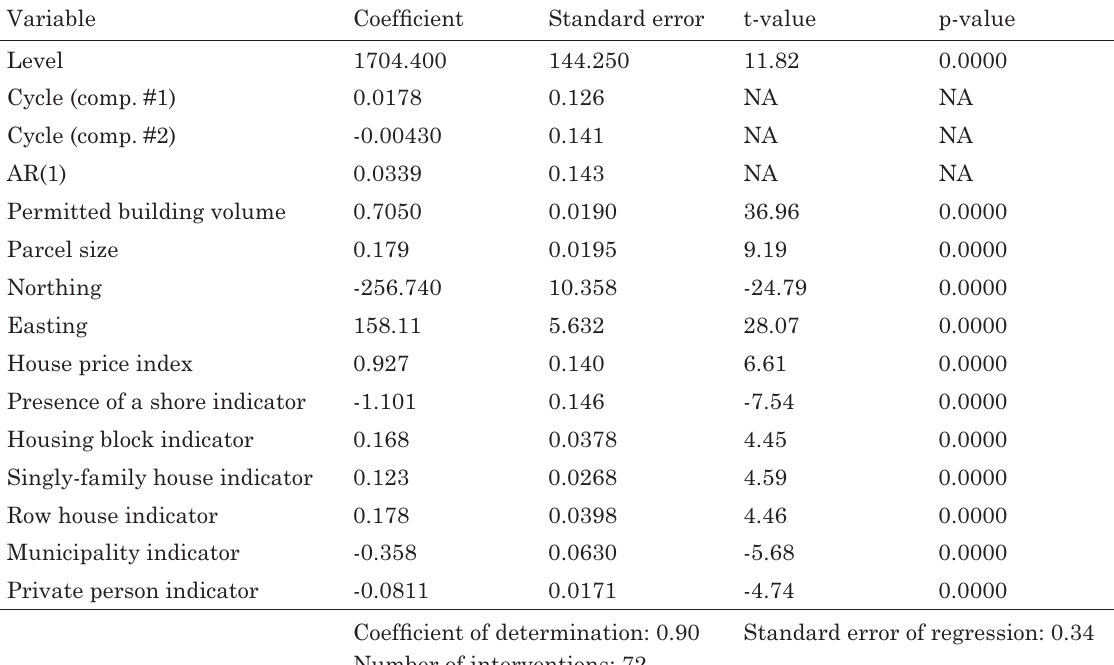
Table 4. Fit and hedonic prices from the structural time series estimation